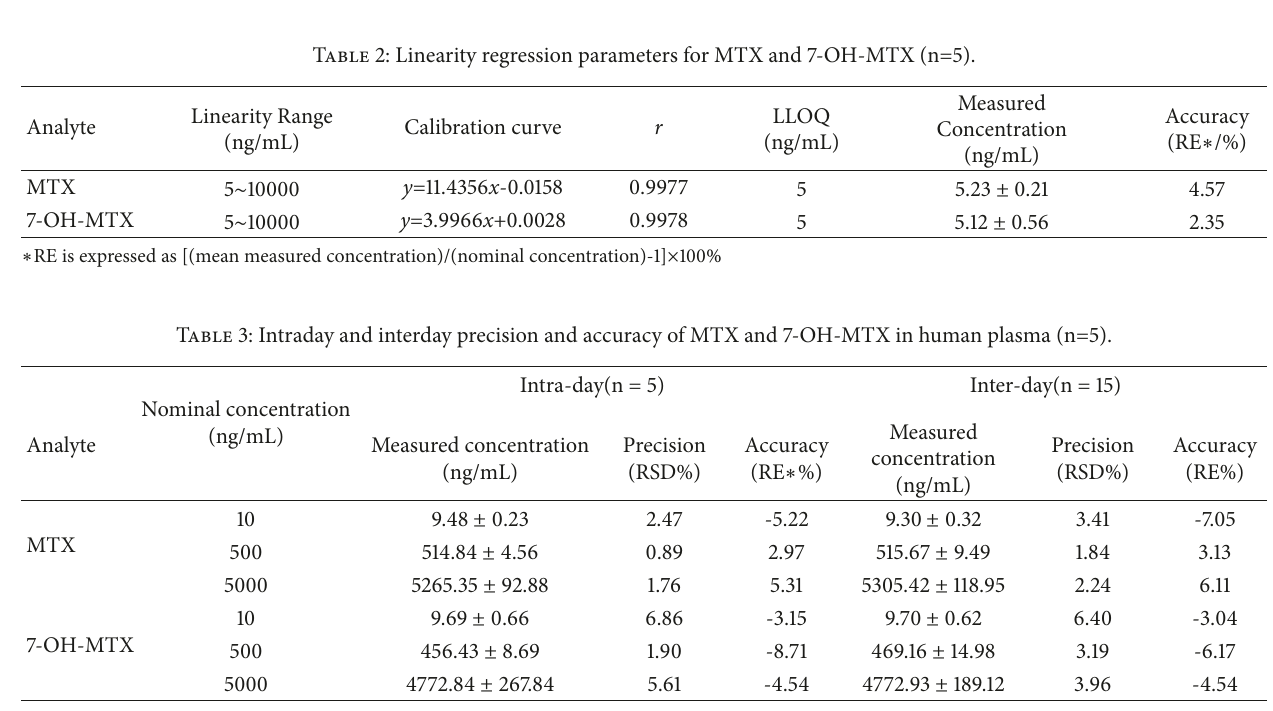
Table 4: Stability of MTX and 7-OH-MTX in different conditions (n=5).